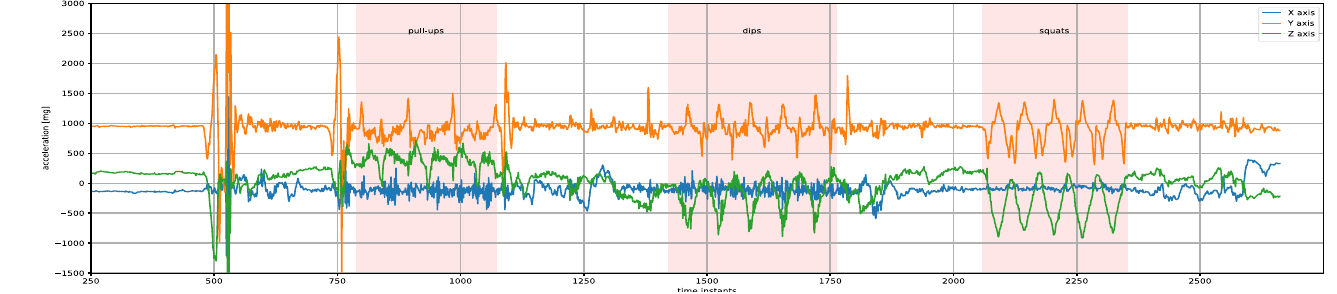
Figure 2. Raw acceleration signals from a sensor placed on the chest of a participant performing three pull-ups, five dips and five squats.